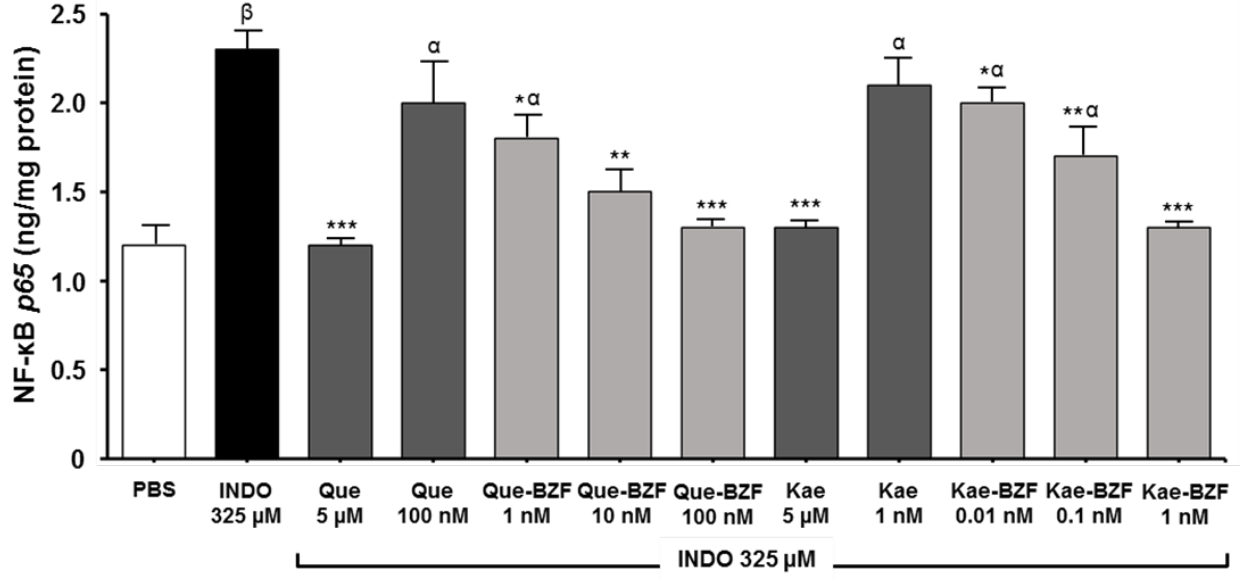
Figure 7. Effects of quercetin, kaempferol, and the respective BZF on Nuclear Factor kappa B activation by indomethacin. Caco-2 cells were incubated with INDO for 40 min in the presence of Que, Kae, Que-BZF, and Kae-BZF, and the NF-kB p65 subunit was assessed in the nucleus. Significant differences: * p < 0.05, ** p < 0.01, and *** p < 0.001 relative to INDO-treated cells, and α p < 0.01 and β p < 0.001 relative to PBS-treated cells.